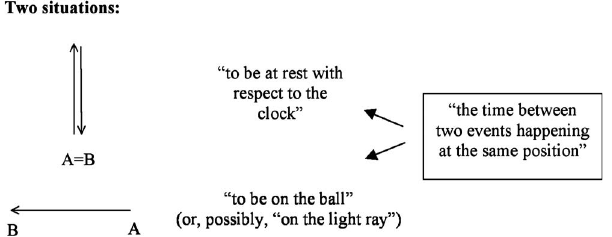
FIG. 3. Students’ coordination at the second stage. (cid:1) The light ray version of the exercise, being “on the light ray,” must be understood only as a limiting case.